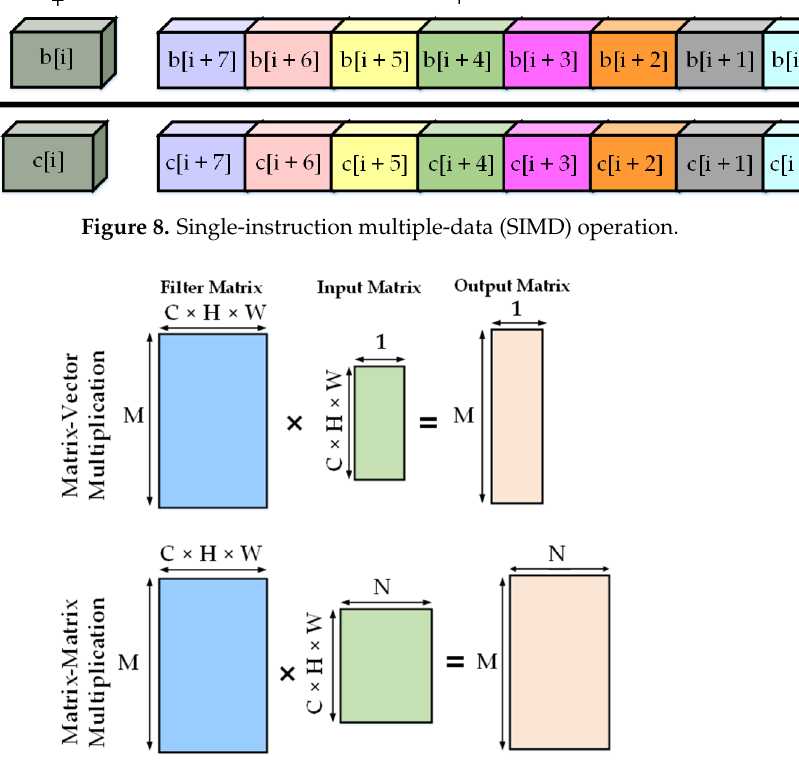
Figure 9. Mapping of fully connected (FC) layers onto matrix multiplication.